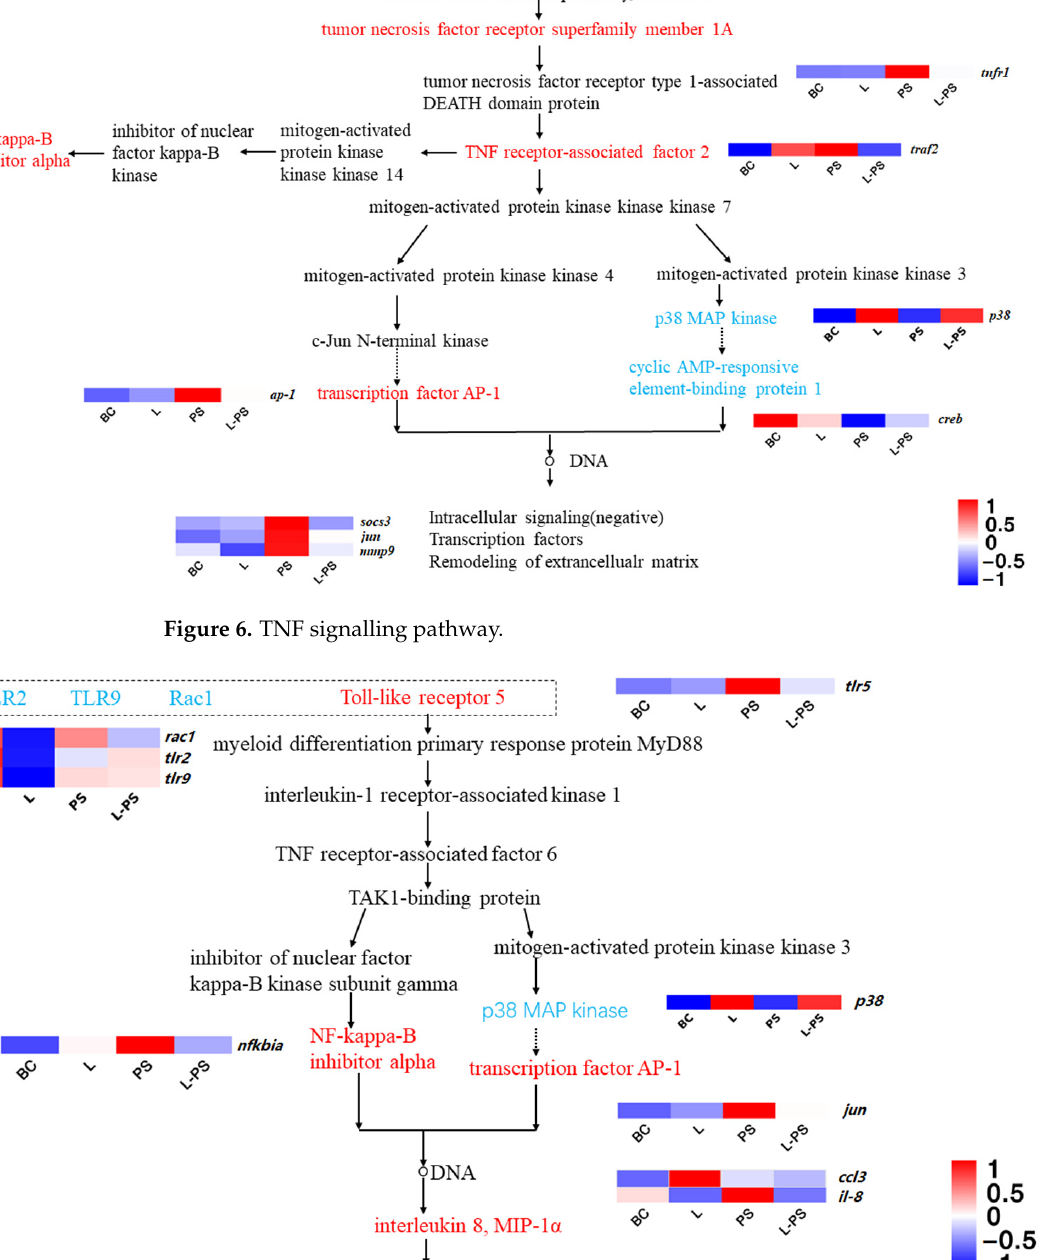
Figure 8. Intestinal immune network for IgA production. 3.7. Validation of DEGs by qRT-PCR To validate the expression profiles of genes identified through RNA-Seq, we ana- lysed the relative mRNA levels of the following six differentially expressed genes ( mmp9 , socs3 , cxcr4 , nfkbia , rbp2 , and calr ) by qRT-PCR (Figure 9). Our results showed that the qRT- PCR results and the results obtained through RNA-Seq were consistent (Figure 10).